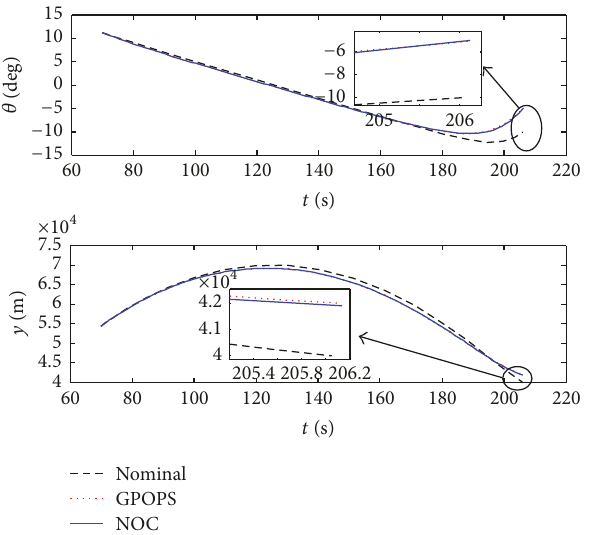
Figure 3: Curves of altitude and flight path angle.